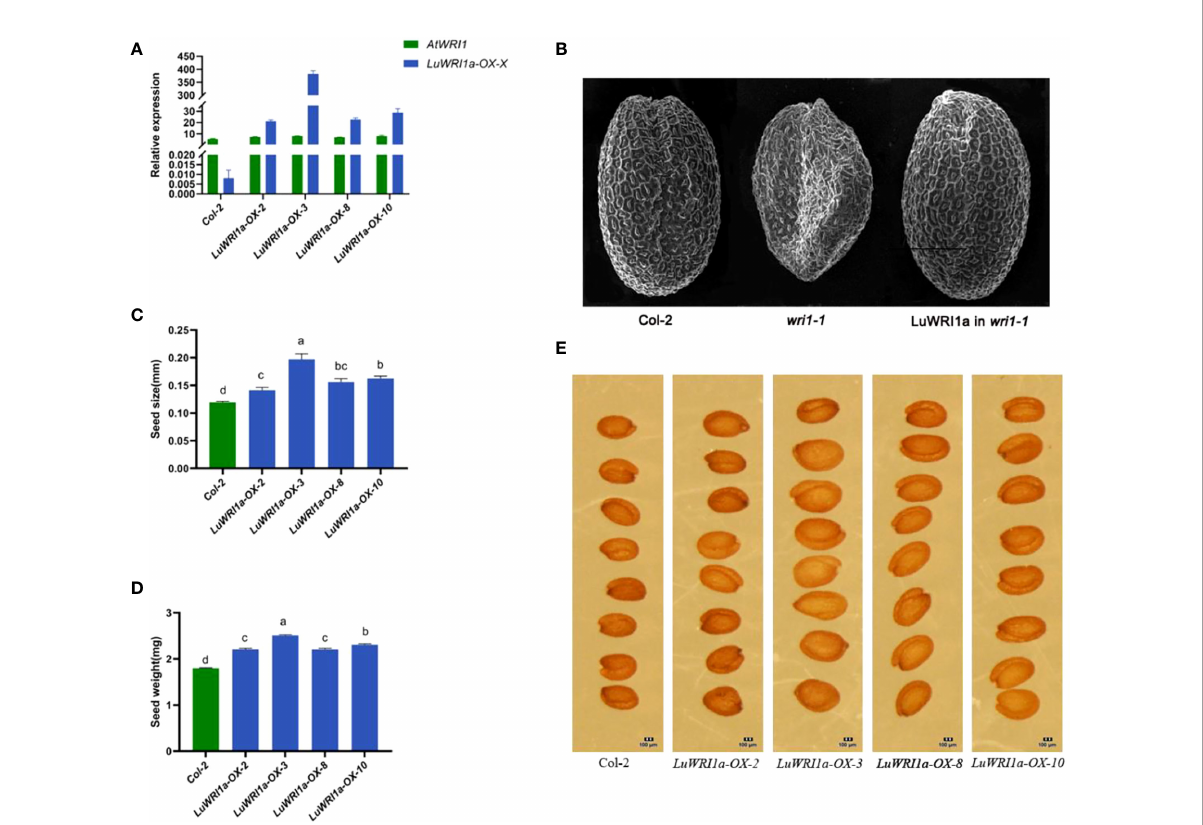
FIGURE 3 Functional analysis of LuWRI1a in A. thaliana seeds. (A) Expression pro fi les of LuWRI1a were established by qRT-PCR in the seeds of Arabidopsis transgenic lines and null transgenic (Col-2). LuWRI1a overexpression transgenic Arabidopsis lines were LuWRI1a-OX-X , including LuWRI1a-OX-2 , LuWRI1a-OX-3 , LuWRI1a-OX-8 , and LuWRI1a-OX-10 . (B) The wrinkled seed phenotype of Arabidopsis was enhanced by the LuWRI1a gene. Images of mature seeds of the null transgenic (Col-2), mutant ( wri1-1 ), and wri1-1 expressing LuWRI1a . Scanning electron microscopy was utilized in order to investigate the seed phenotype. Bar = 200 m m. (C) Size analysis of null transgenic and transgenic Arabidopsis seeds. Error bars represent SD (n = 8). (D) Seed weight analysis of null transgenic and LuWRI1a transgenic lines, mg/100 per. Error bars represent SD (n = 9). (E) Images of wild-type and transgenic LuWRI1a in null transgenic background. Bar = 100 m